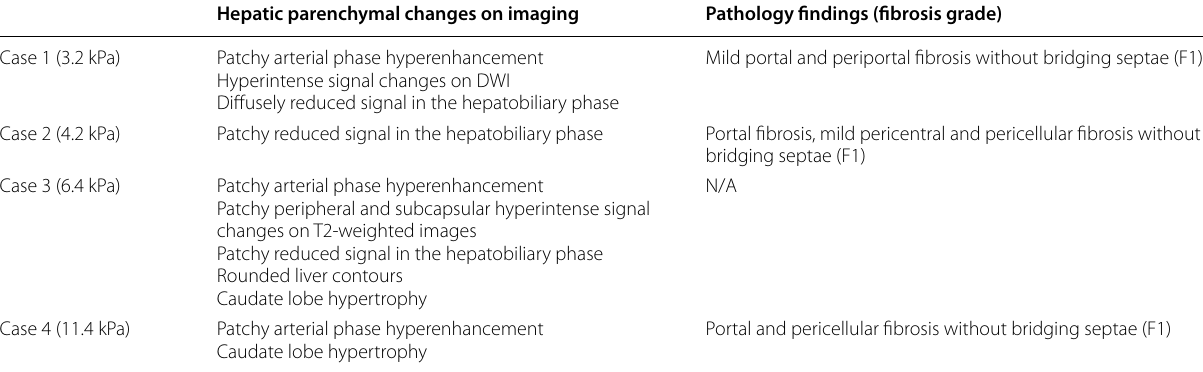
The depicted kPa values correspond to the liver stiffness values assessed with MR elastography Cases 1, 2 and 3 received MRI with the hepatospecific contrast agent gadoxetate disodium, Case 4 received the extracellular contrast agent gadoteric acid